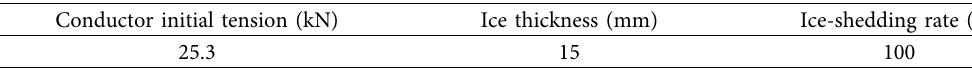
Table 2: Parameters of iced transmission line.